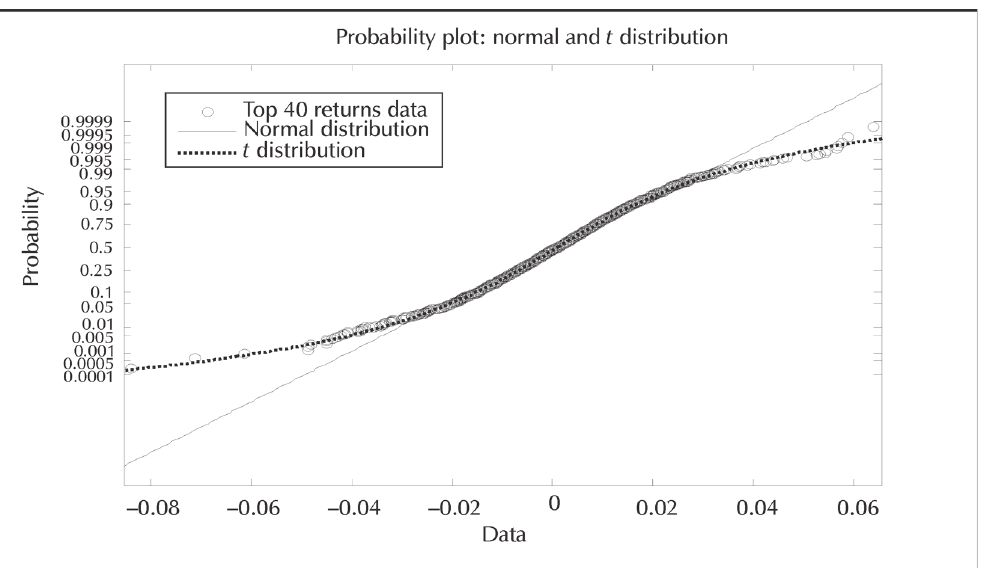
Probability plots with normal and t distributions